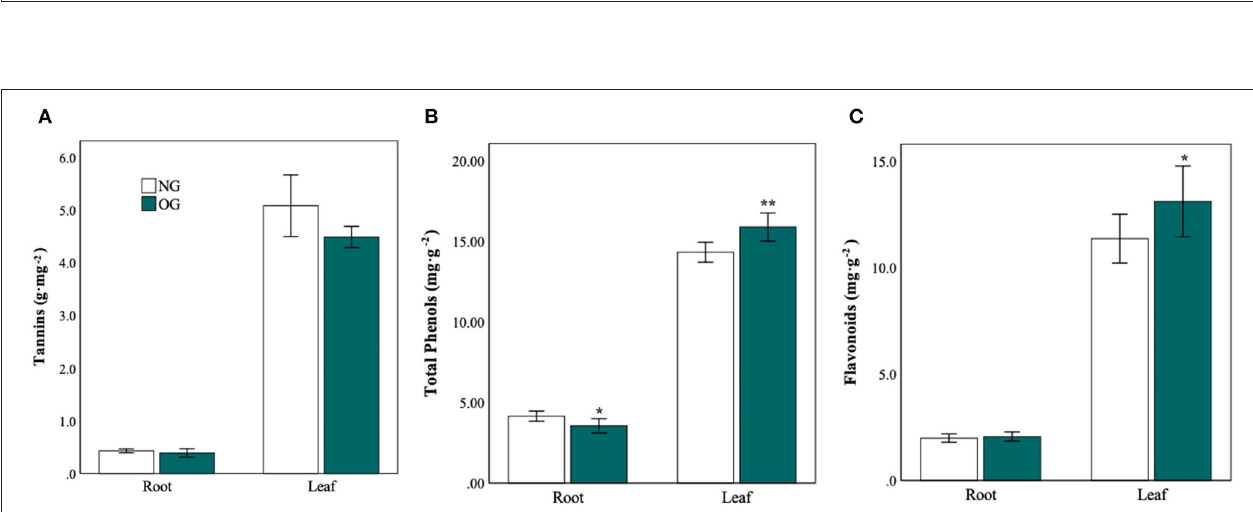
FIGURE 5 | Plant defense compounds in roots and leaves in response to a legacy of OG metabolism. (A) Tannins, (B) flavonoids, and (C) total phenols in roots and leaves in response to two conditions. Statistical significance is denoted by *** P < 0.001; ** P < 0.01; * P < 0.05. Error bars denote the standard error of the mean.